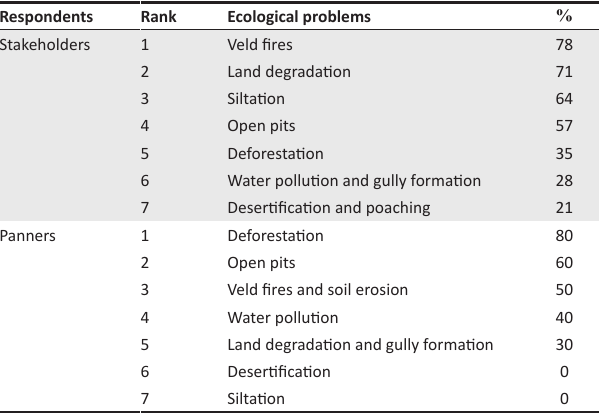
TABLE 7: Ranking of ecological problems.